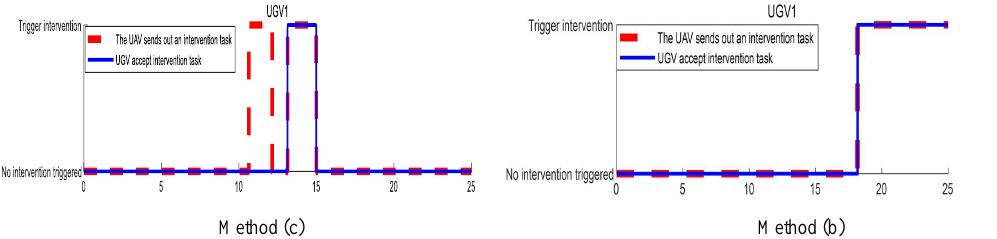
Figure 10. The figure shows the event-triggered performance of the method (c) and method (b), respectively. For method (c), After 18.1s, the UAV continues to send wrong intervention tasks, and the UGV continues to accept the wrong tasks. For method (b), the UAV sends the wrong intervention tasks at 10.6 s, which is refused by the decision maker based on MPC of the UGV. At 13.1 s, the UAV sends a correct intervention task, which is accepted by the